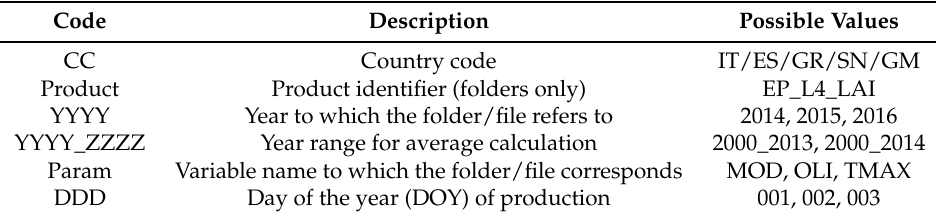
Table 1. Naming conventions of folder and data